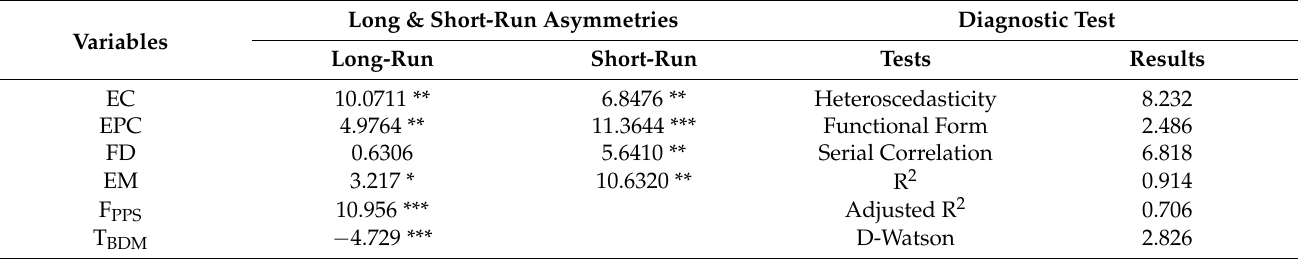
Table 4. Wald test and Diagnostic test.